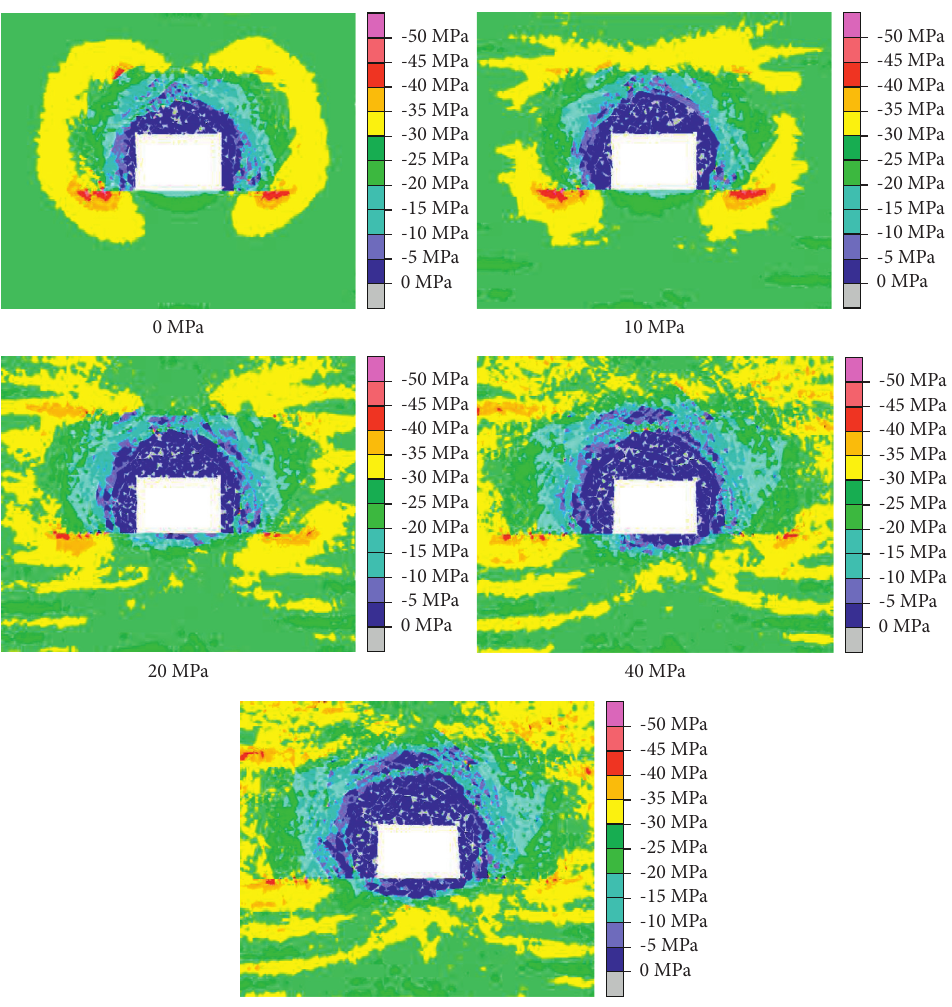
Figure 6: Maximum principal stress distribution of roadway with different mine earthquake